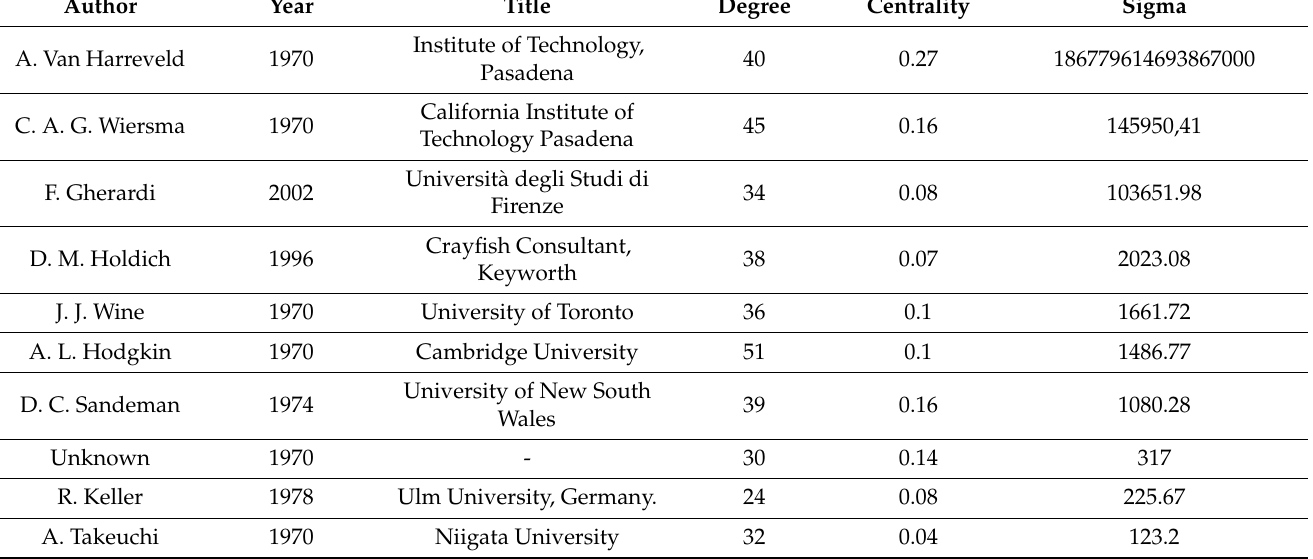
Table 5. Top 10 most influential authors in the field of crayfish research, based on the Sigma score, with the highest at the top.